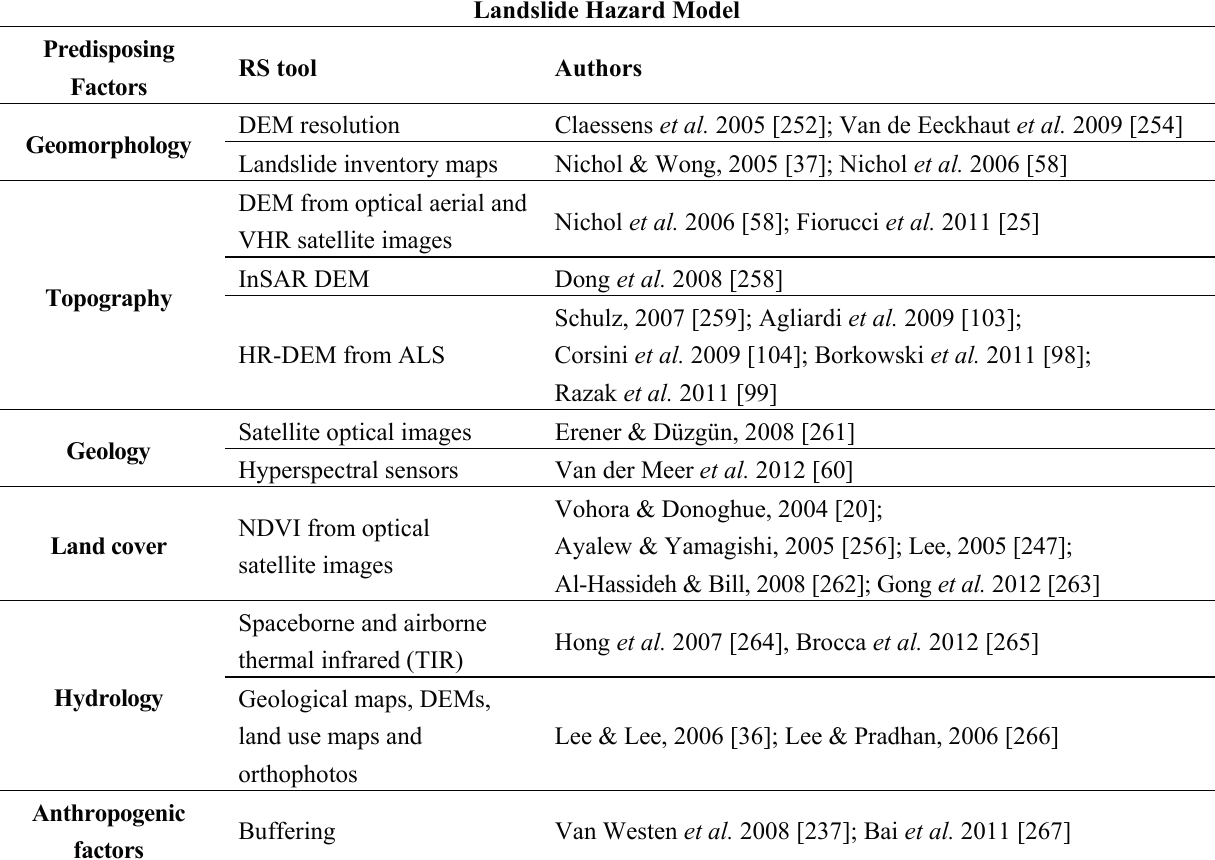
Table 3. Literature contributions on Remote Sensing for landslide predisposing factor